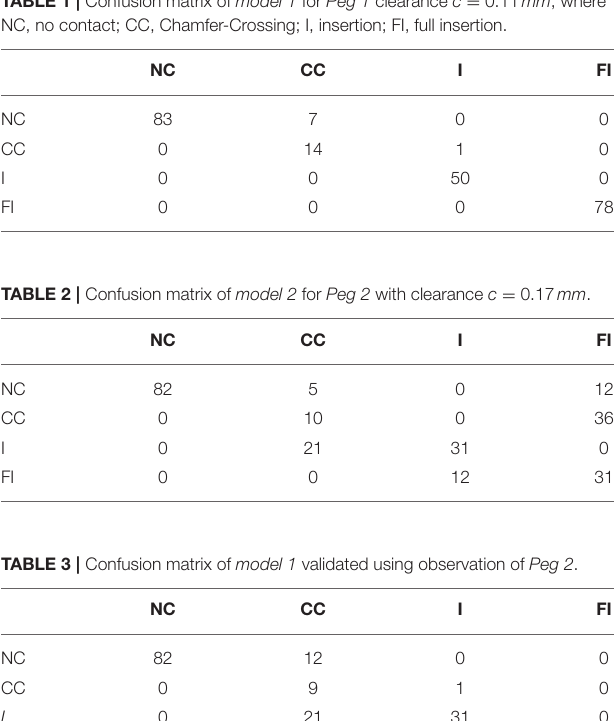
TABLE 5 | Confusion matrix of HMM trained with K-means 10 segments.